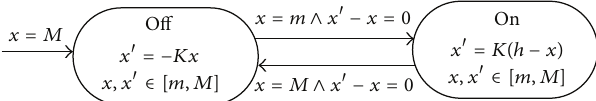
Figure 1: Hybrid automaton for a